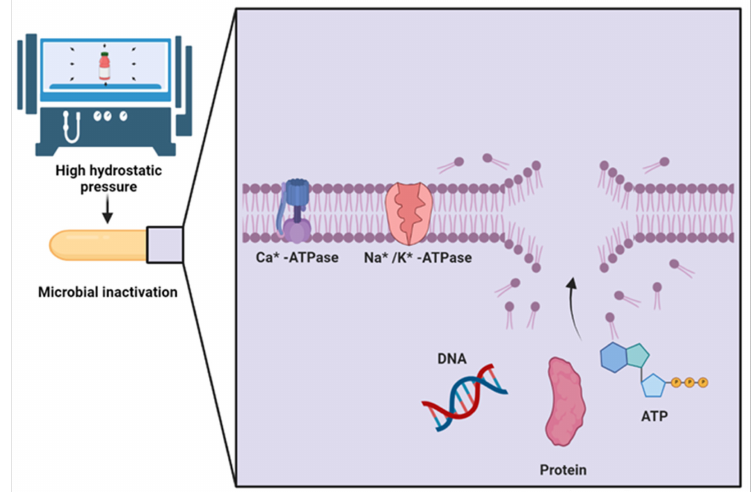
Figure 3. Mechanisms of microbial inactivation by high hydrostatic pressure [80] (Created with BioRender. com; accessed on 30 March 2022). DNA: Deoxyribonucleic acid, ATP: Adenosine